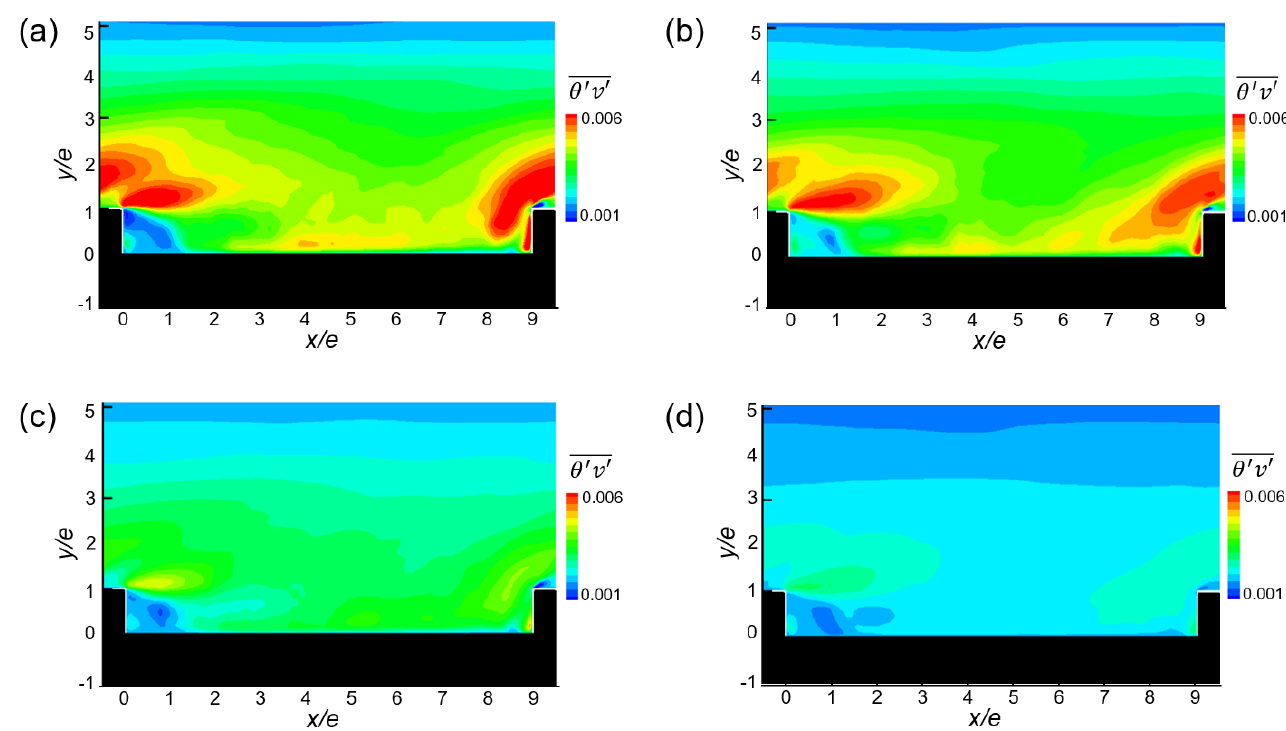
Figure 7. Turbulent heat flux 𝜃′𝑣′(cid:3364)(cid:3364)(cid:3364)(cid:3364)(cid:3364) contours for ( a ) K* = 566.26, ( b ) K* = 100.00, ( c ) K* = 10.00, and ( d ) K* = 1.00.